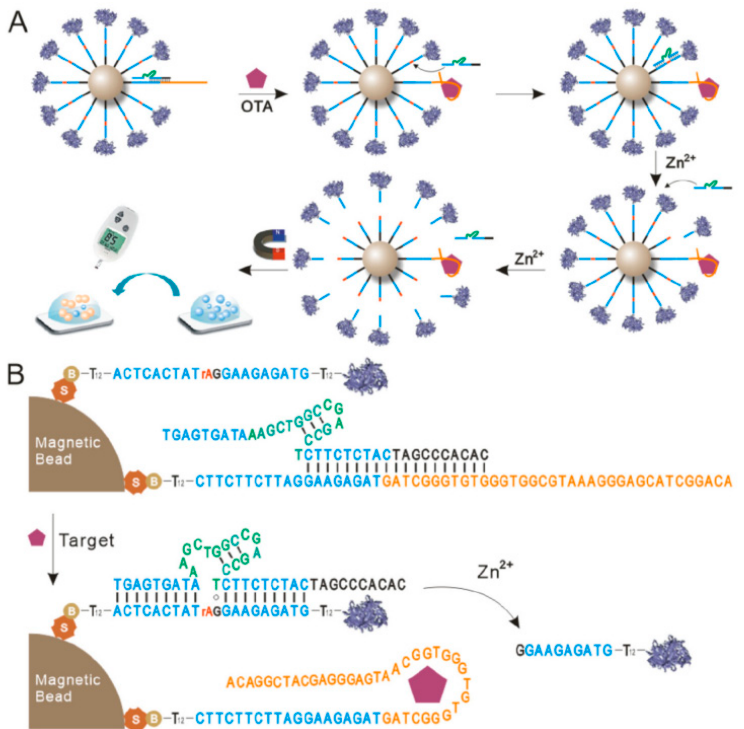
Figure 12. Schematic diagram of apta-sensing platform for OTA detection through DNAzyme amplification. ( A ) stepwise synthesis of magnetic removal beads (MB) and ( B ) OTA brought the displacement of DNAzyme, substrate − DNAzyme complex, and further invertase-labeled substate was released. Reproduced from [110]. Copyright 2021 ACS Publications.